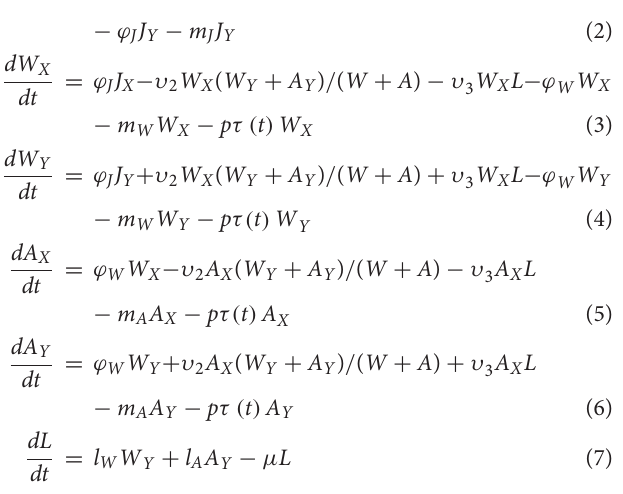
Frontiers in Ecology and Evolution |